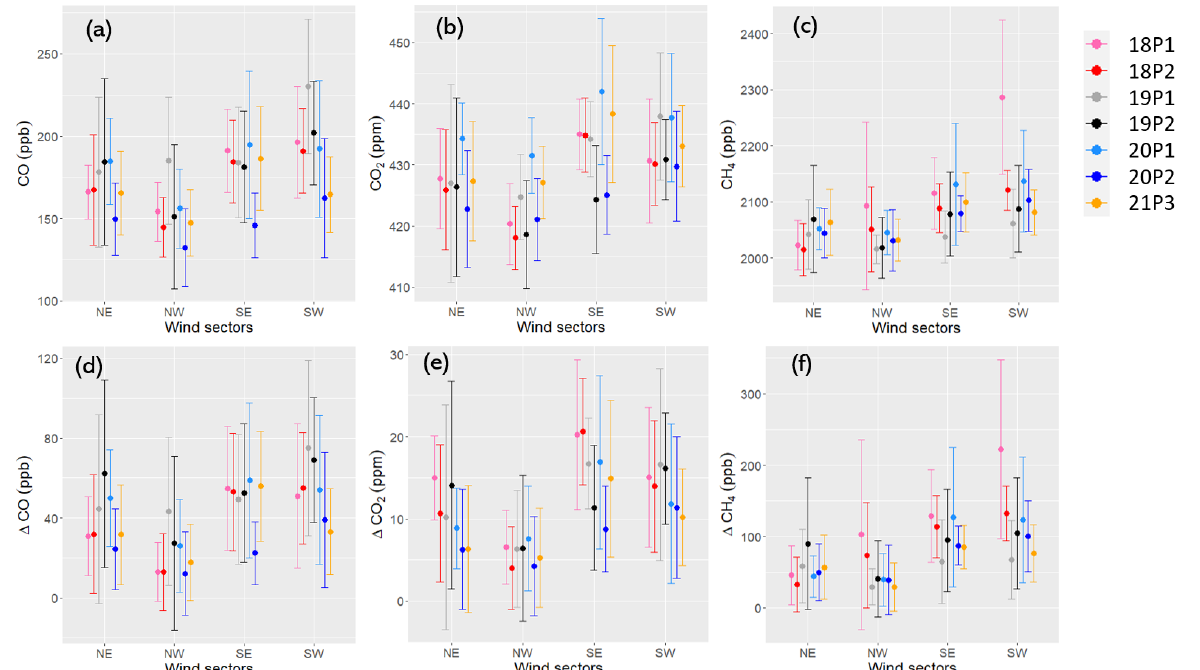
Figure 4. Plots of afternoon (12:00 to 16:00 local time) average of ( a ) CO, ( b ) CO 2 , ( c ) CH 4 , ( d ) ∆ CO, ( e ) ∆ CO 2 , and ( f ) ∆ CH 4 in four wind direction sectors over the seven periods examined. These periods (see legend) are defined in the manuscript (see Table 2): “18P1” for 2018 Period 1, “18P2” for 2018 Period 2, etc. Circles denote the mean, and error bars denote the standard deviation. Wind direction = 0 ◦ means wind is from north. NE: wind is from northeast (0 ◦ –90 ◦ ); SE: wind is from southeast (90 ◦ –180 ◦ ); SW: wind is from southwest (180 ◦ –270 ◦ ); NW: wind is from northwest (270 ◦ –0 ◦